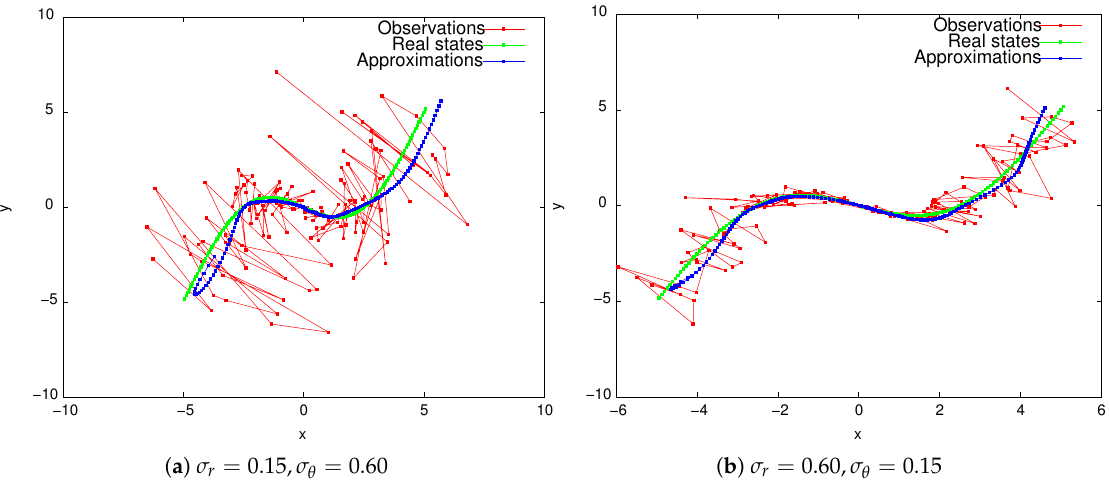
Figure 3. Taking error correlation into account when using range and bearing observations of different accuracies. The smoothing parameter is η = 100 for both